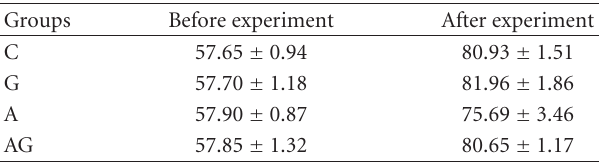
Table 1: Body weight of groups before and after experiment ( n =